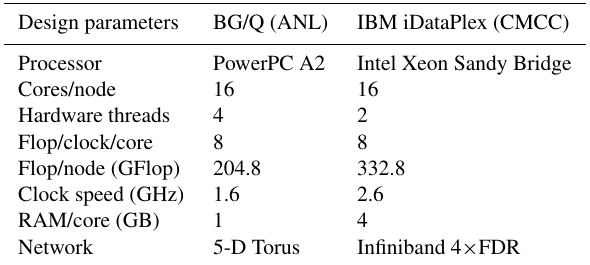
Figure 1. Example of PELAGOS025 decomposition on 54 subdo- mains. There are five subdomains with land points only (marked by an X). These subdomains are not included in the computation. Table 1. Architecture parameters related to the BlueGene/Q (named VESTA), located at the Argonne Leadership Computing Facilities (ALCF/ANL) and the iDataPlex equipped with Intel Sandy Bridge processors (named ATHENA), located at the